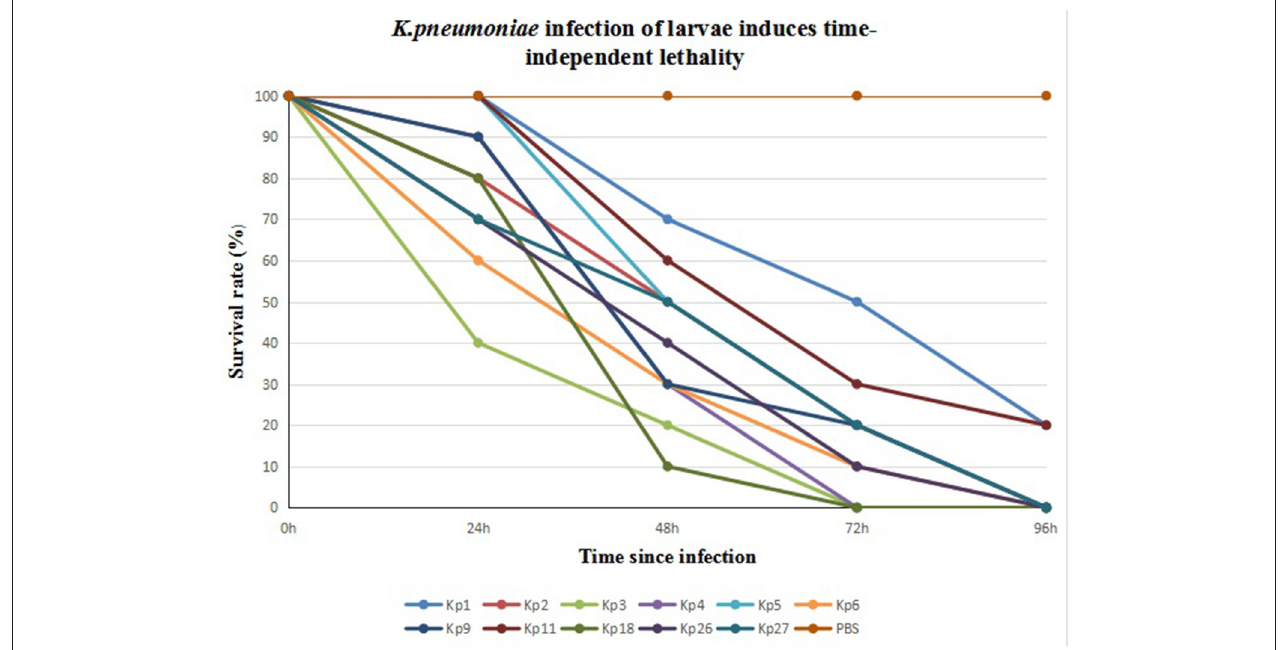
FIGURE 2 | Eleven CR-hvKP isolates from six patients infection of G. mellonella larvae induces time-dependent lethality. The G. mellonella larvae injected with PBS were used as control.